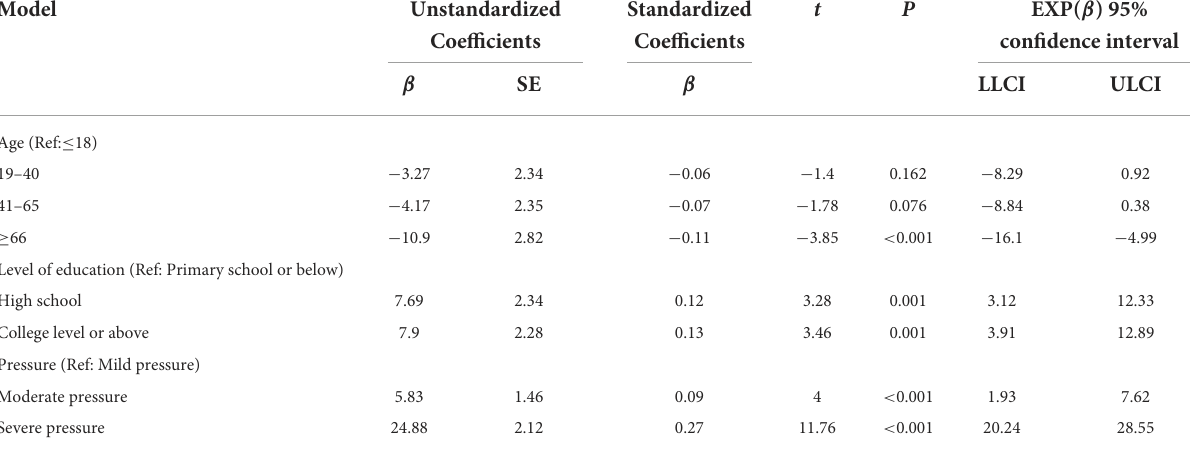
TABLE 7 Regression model of accept willingness to organ donation among people high-frequency media user.